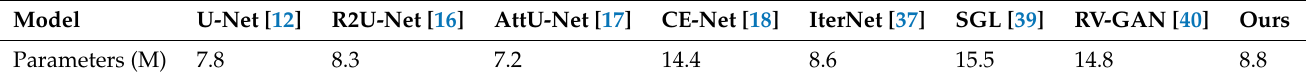
Table 2. Parameter comparison with state-of-the-art methods.